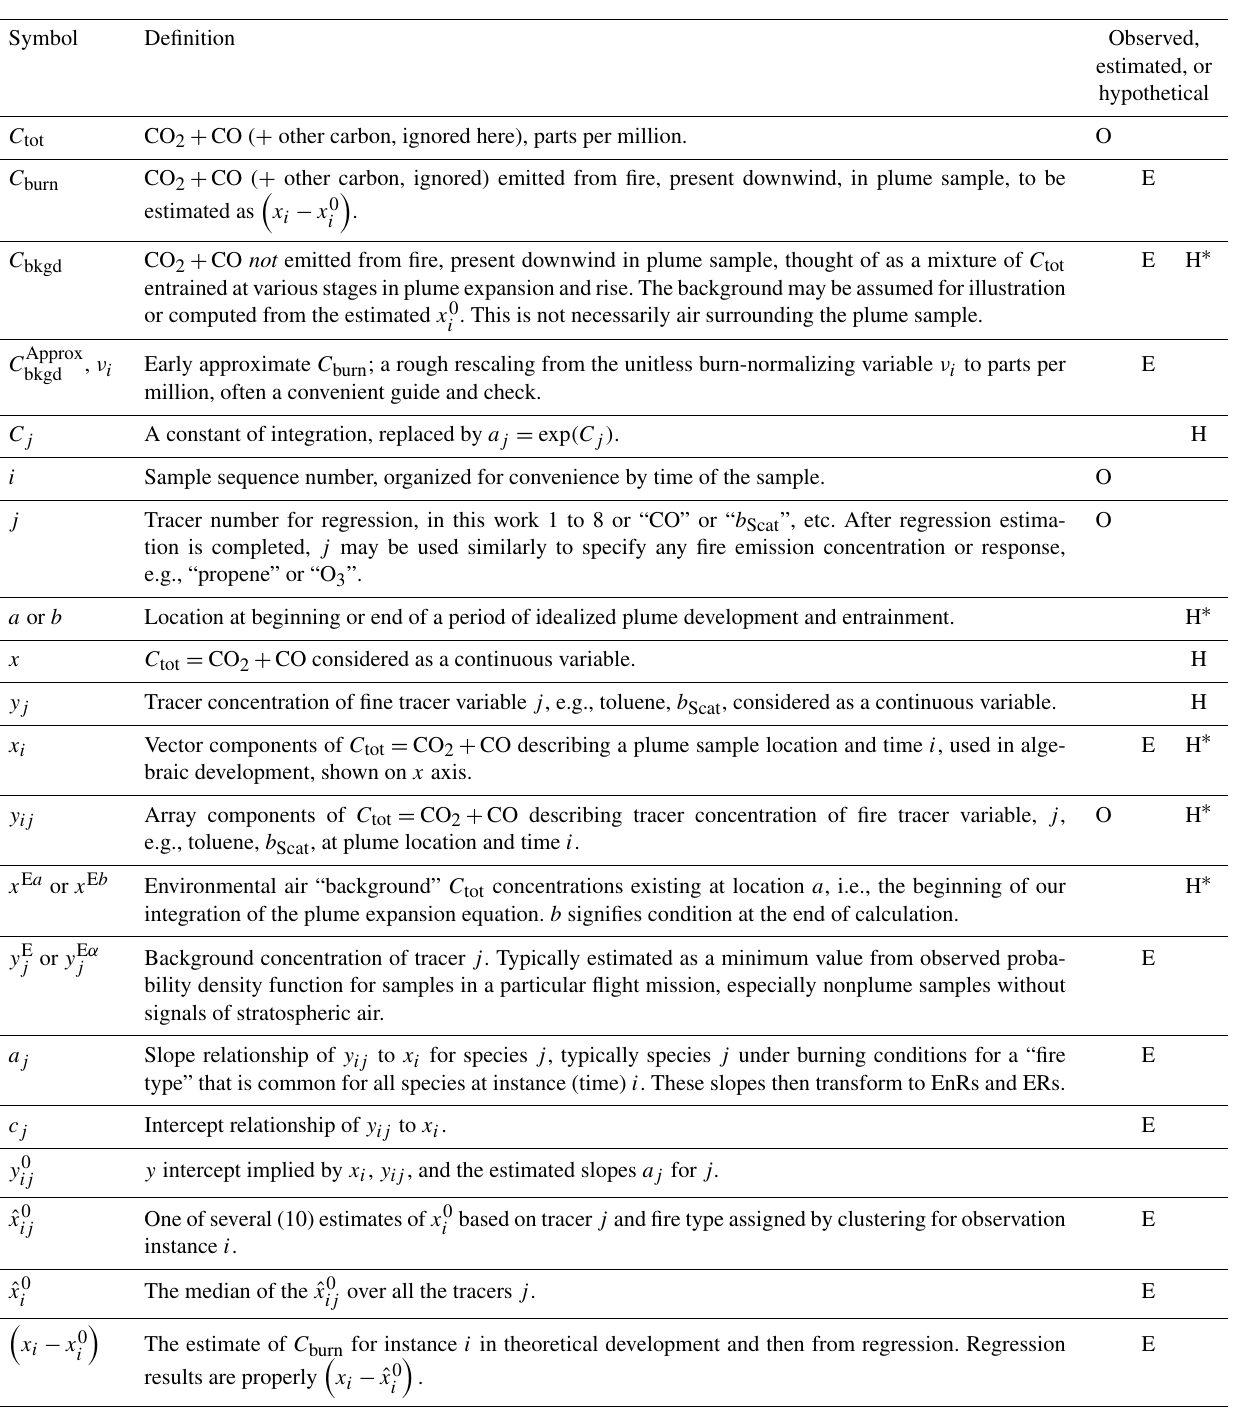
Table 2. Table of